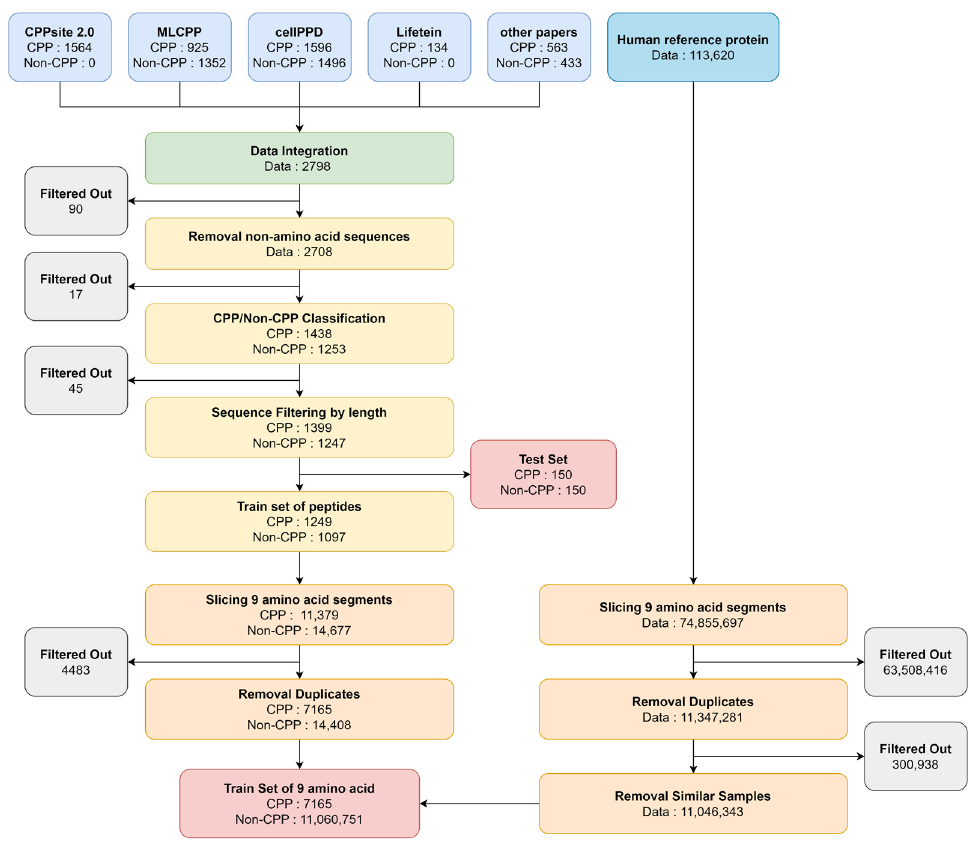
Figure 2. Dataset preparation. Peptide sequences derived from the human reference protein are used as the negative set.